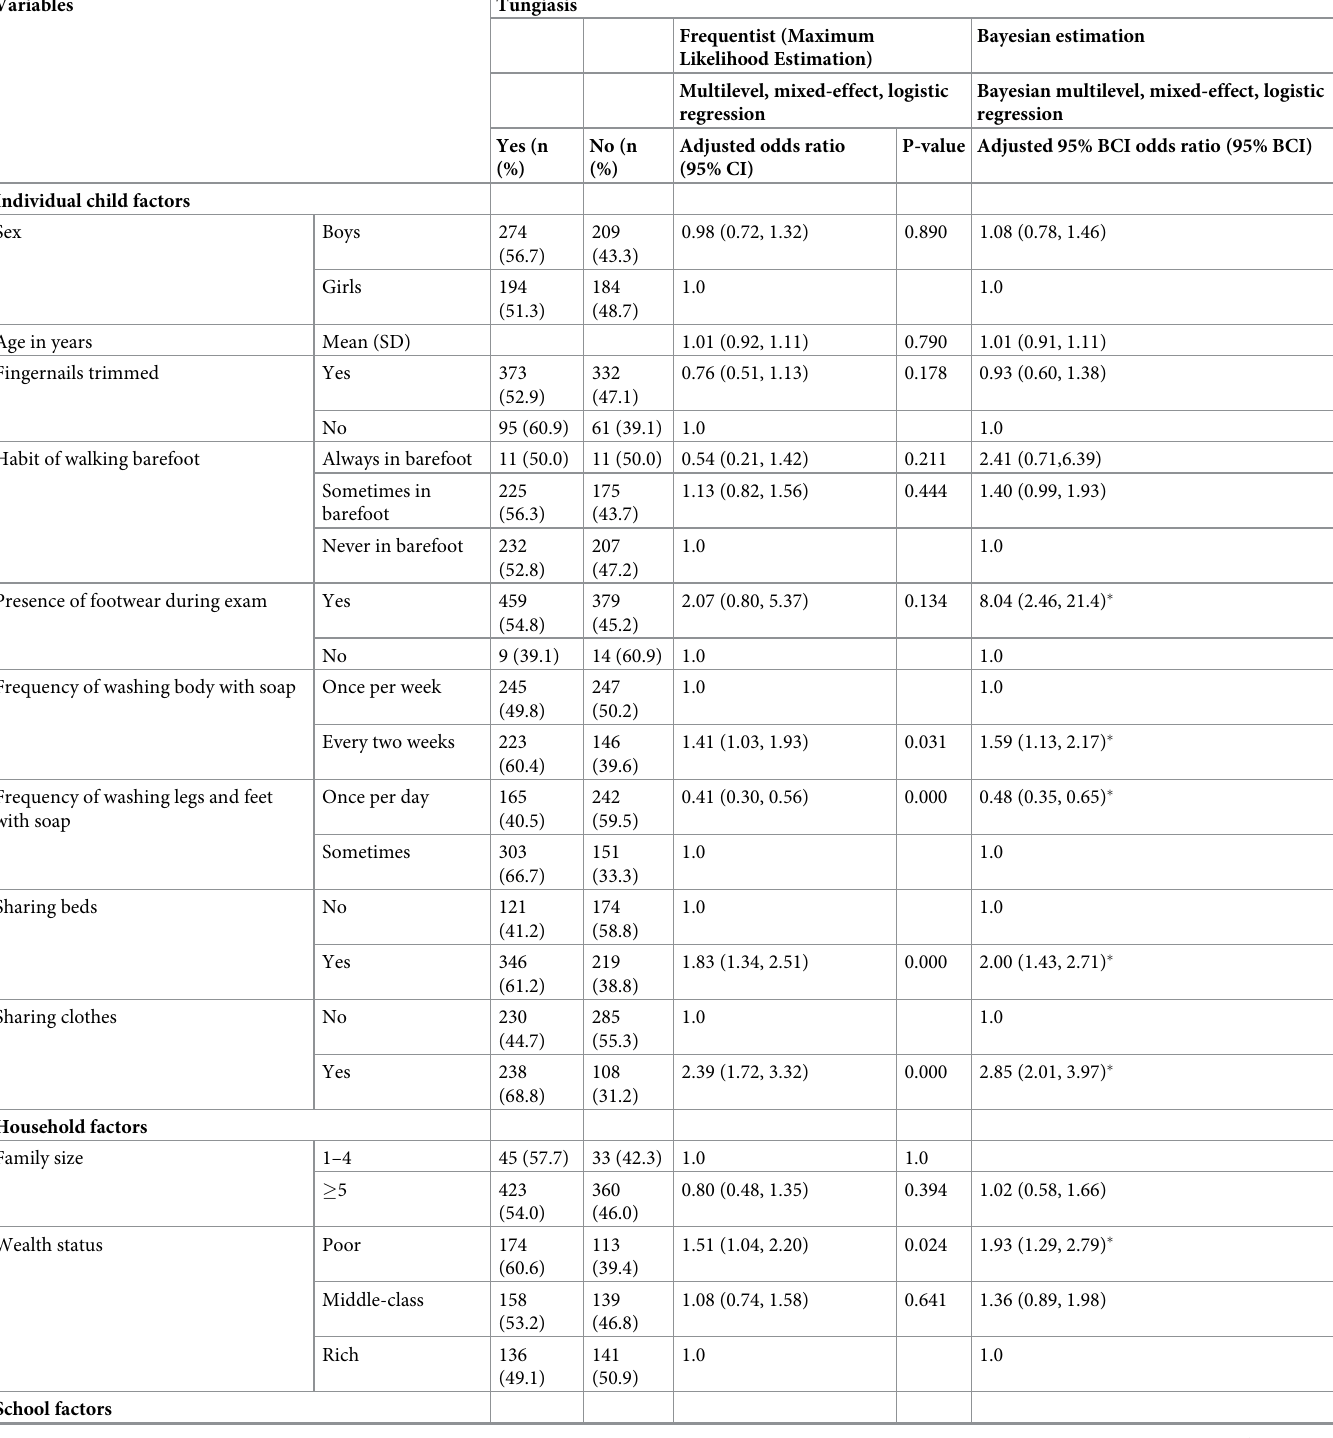
Table 3. Frequentist and Bayesian multivariate, multilevel, mixed-effect, logistic regression analysis of tungiasis among schoolchildren in the Wonago district, southern Ethiopia,